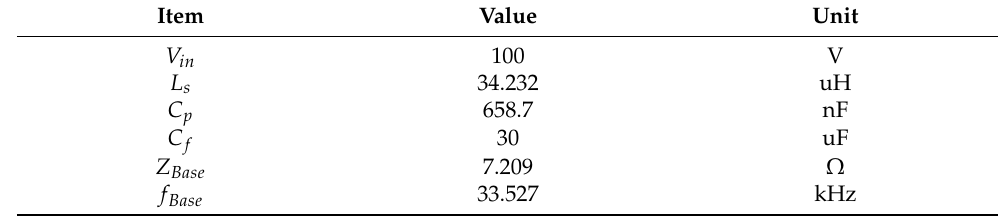
Table 5. The parameters used to simulate the model in Figure 9 with dynamic load.